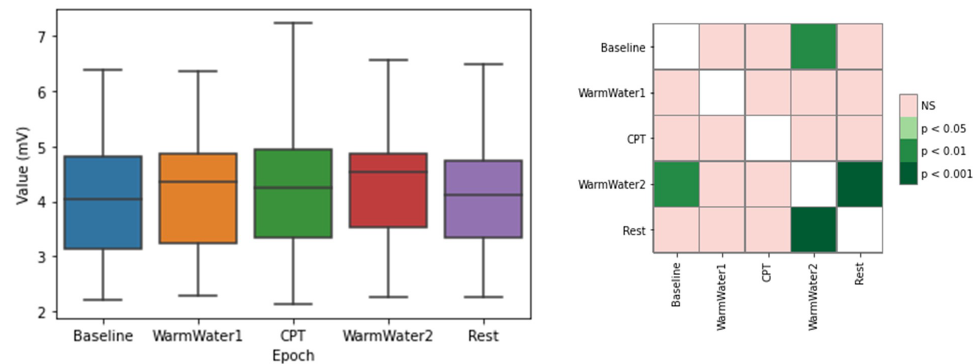
Figure 4. Boxplot for the mean maximum ECG cycle values ( left ) and respective matrix of calculated p -values between different epochs, with Bonferroni correction, for the ( right